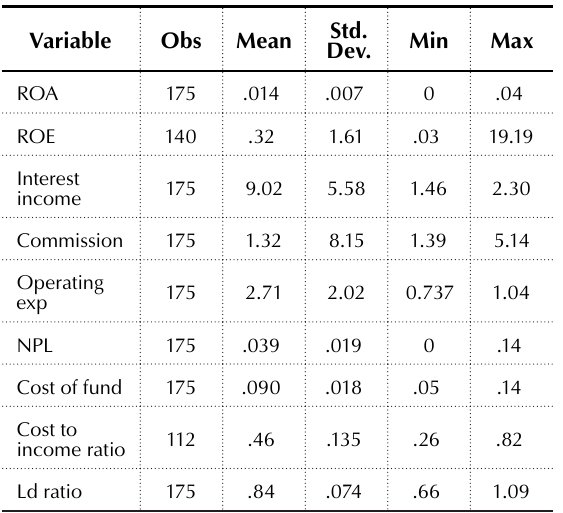
Table 1. Summary statistics